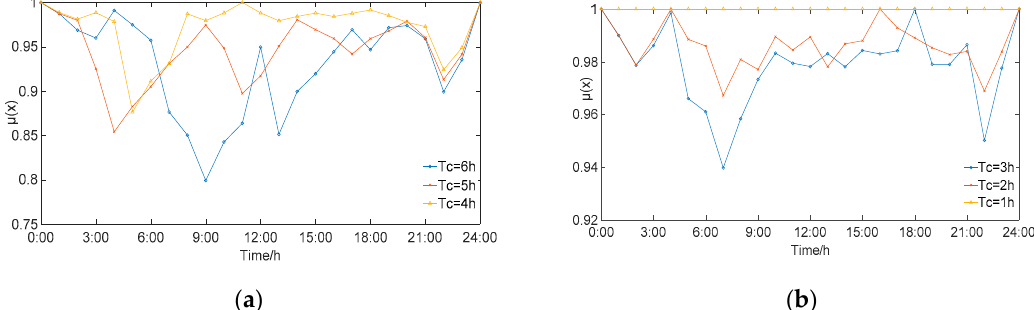
Figure 13. Temperature-based fuzzy membership function value under different time scales of heat dispatched. ( a ) T c = 6, 5, 4 h. ( b ) T c = 3, 2, 1 h.